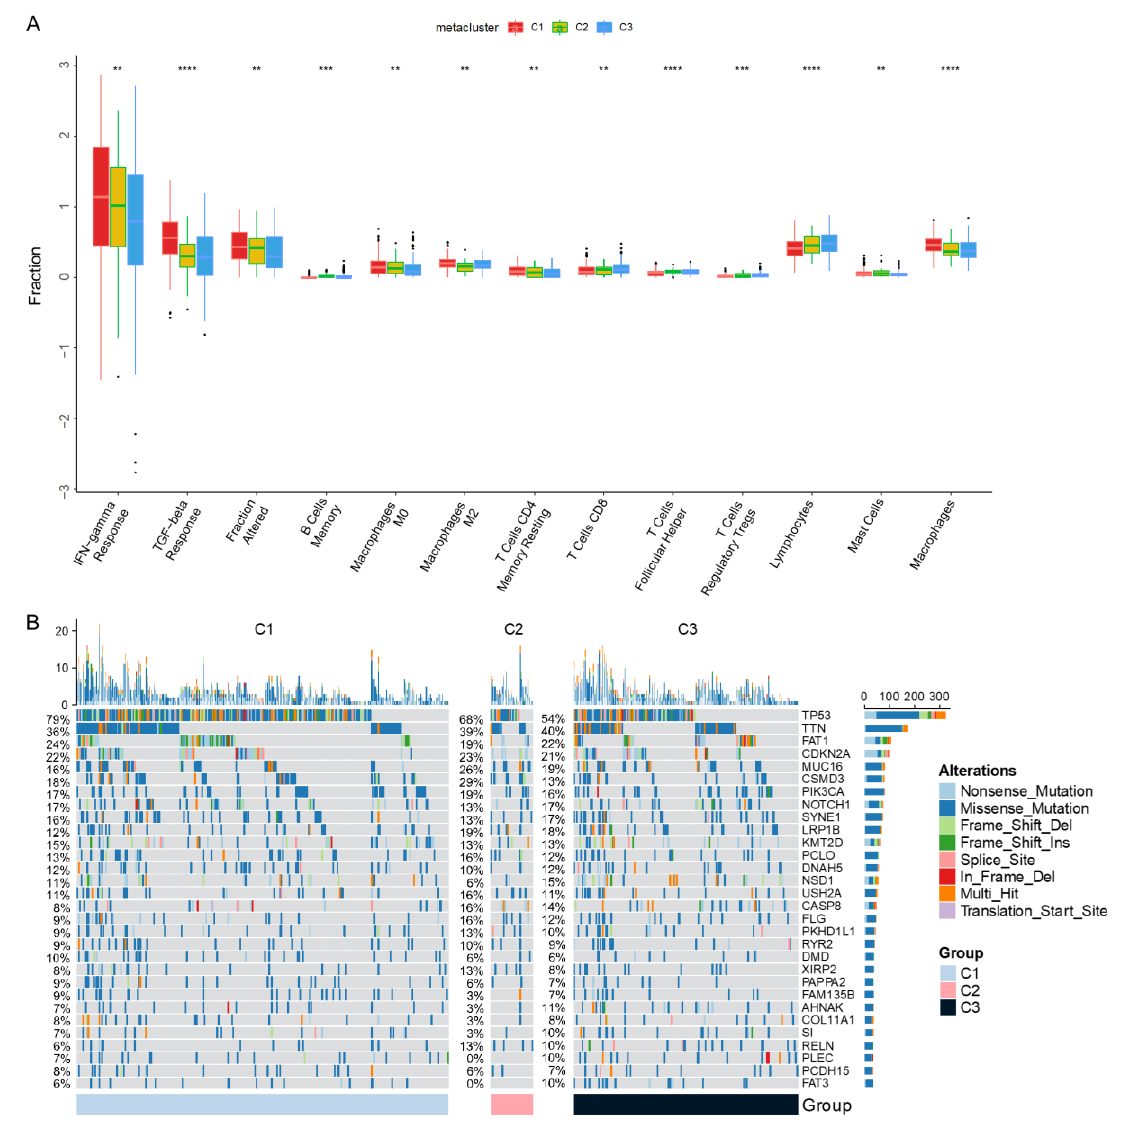
Figure 4. Multiomics analysis of immune subtypes. ( A ) Analysis of immune-related molecular characteristics among immune subtypes. ( B ) The landscape of the genomic alteration of immune subtypes. ** p < 0.01, *** p < 0.001, and **** p < 0.0001.